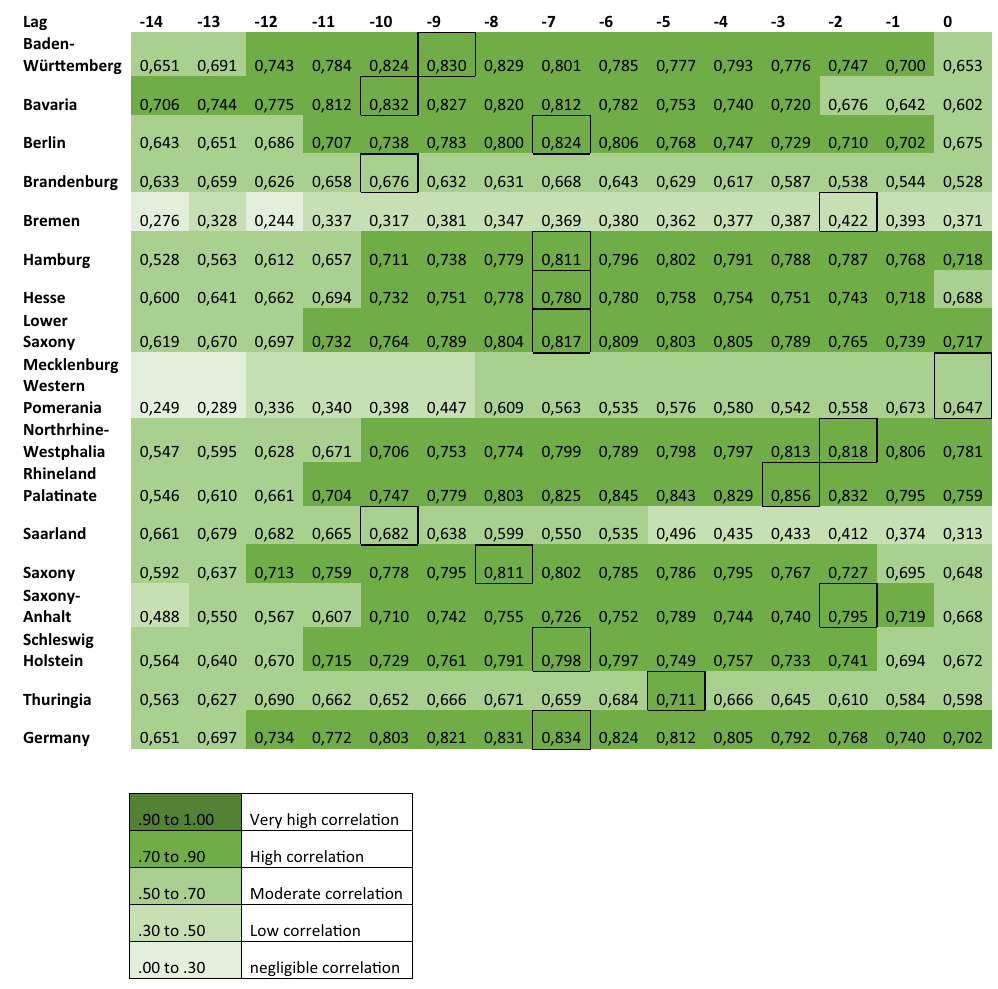
Figure 5. Cross-correlation coefficients displaying the linear association between the RSV of the term ‘RKI’ and officially reported COVID-19